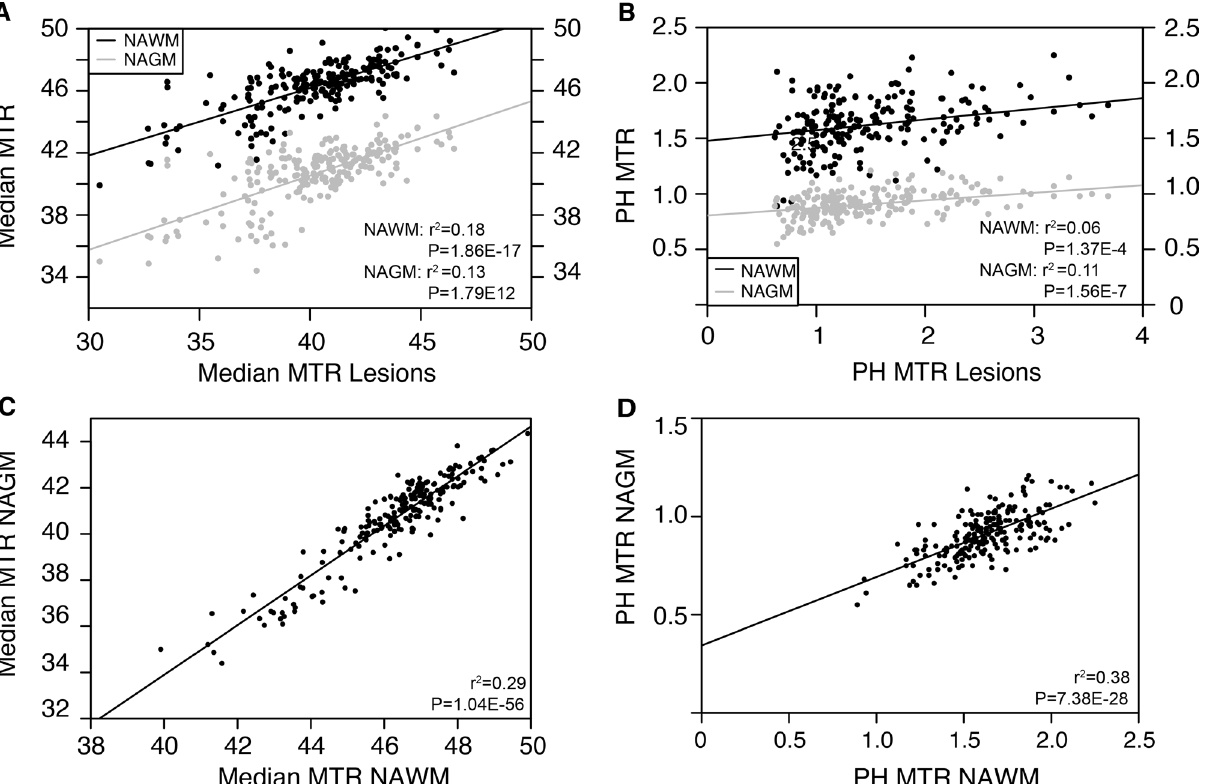
Figure 4. Correlation of MTR over tissue classes within patients. Correlation of ( A ) median and ( B ) peak height MTR in normal appearing tissues versus median and peak height MTR in lesions. Correlation between ( C ) median and ( D ) peak height MTR in NAWM versus NAGM in the cross-sectional study population (N = 213). Adjusted r 2 and P-values result from linear regression with covariates age, gender and MRI protocol. The Bonferroni cut-off for significance of P ≤ 0.05 after correction for multiple testing was 0.00047. MTR magnetization transfer ratio, NAWM normal appearing white matter, NAGM normal appearing grey matter, PH peak height (Image generated with Rv3.6.1, https ://www.R-proje